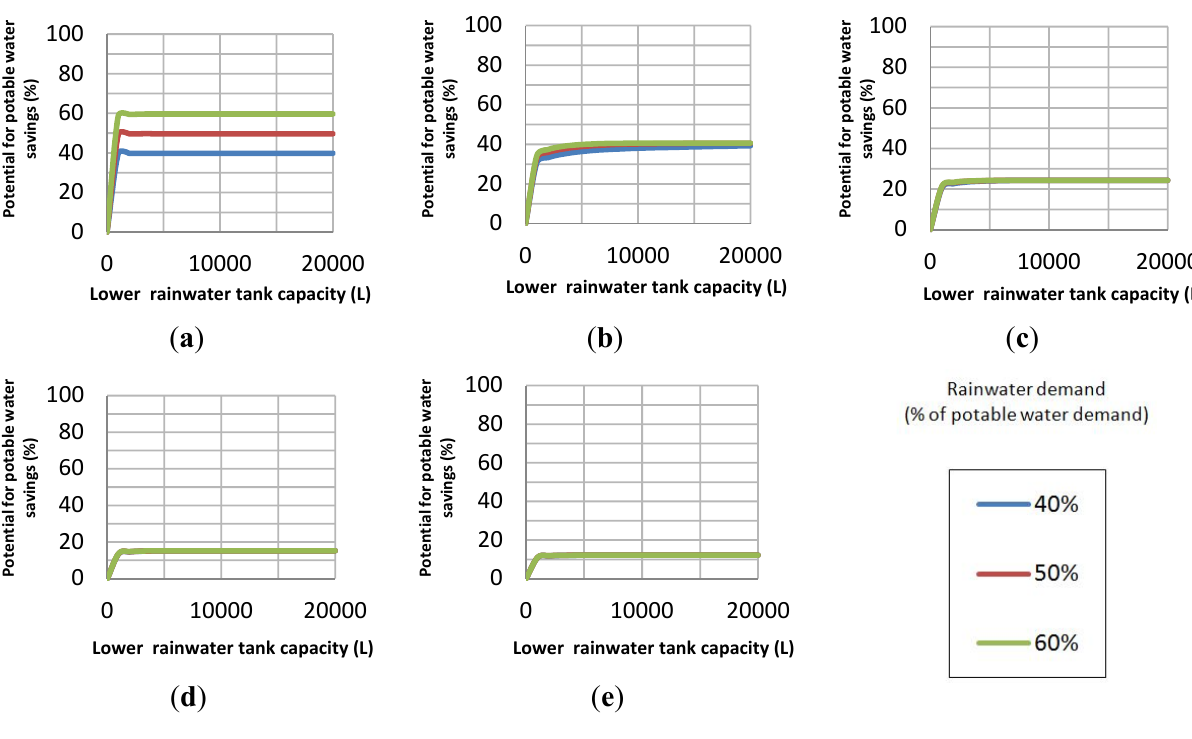
Figure 8. Potential for potable water savings as a function of lower rainwater tank capacity and potable water demand for Berlin, Germany, for a catchment area of 100 m 2 and different potable water demands. ( a ) 100 L per house per day; ( b ) 300 L per house per day; ( c ) 500 L per house per day; ( d ) 800 L per house per day; ( e ) 1000 L per house per